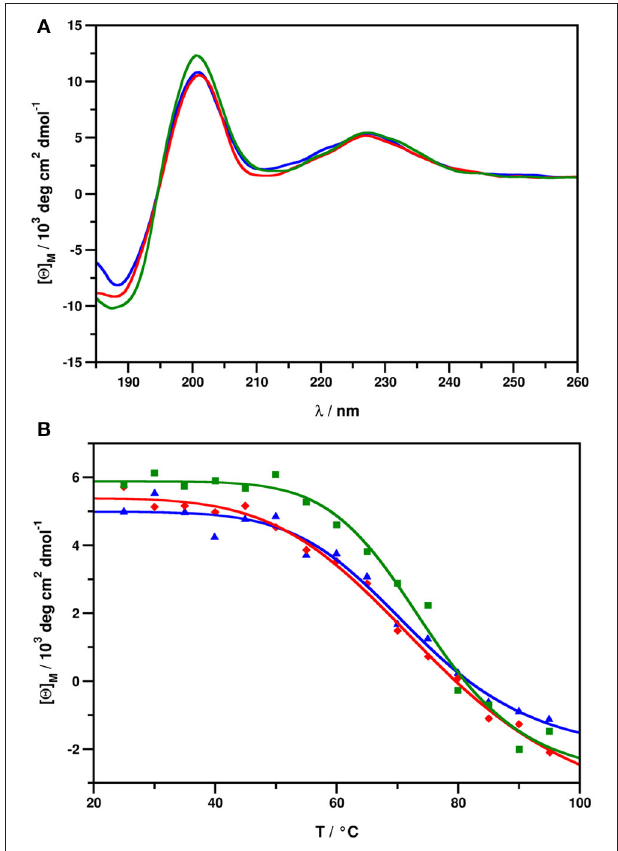
FIGURE 5 | (A) ECD spectra of nNFAP2 (blue), rNFAP2 (red), and sNFAP2 (green), recorded at 25 ◦ C. (B) Thermal unfolding curves measured at 228nm for nNFAP2 (blue, T m = 72.92 ◦ C, R 2 = 0.9837), rNFAP2 (red, T m = 75.79 ◦ C, R 2 = 0.9942), and sNFAP2 (green, T m = 74.94 ◦ C, R 2 = 0.9864).